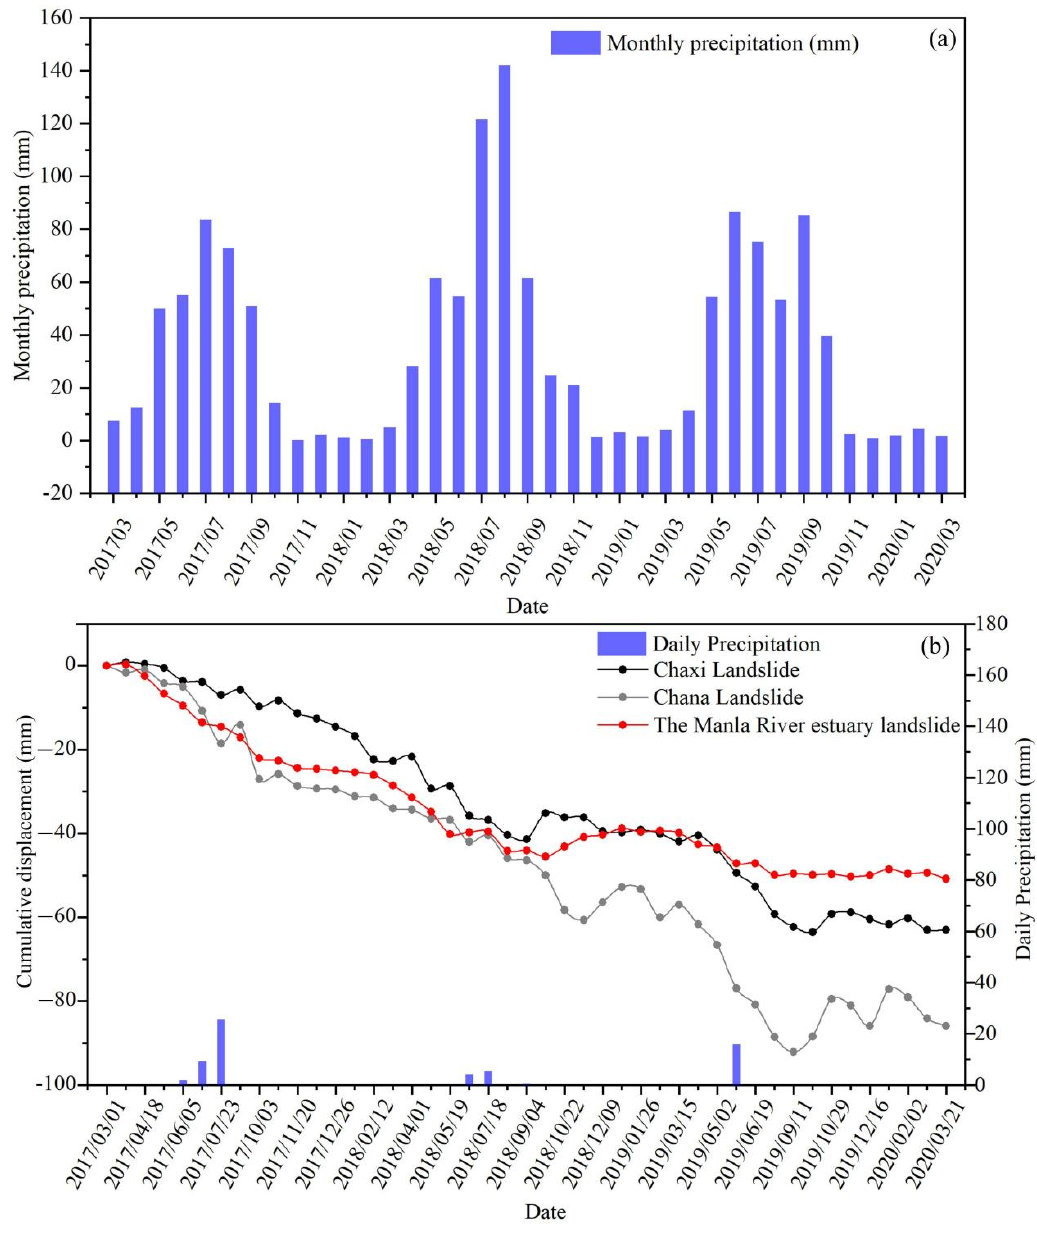
Figure 22. Relationship between precipitation and landslide deformation. ( a ) Monthly precipitation at the Longyangxia Reservoir; ( b ) landslide cumulative displacement and daily precipitation, from 2017 to 2020.